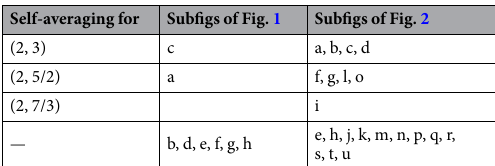
Self-averaging for Subfigs of Fig. 1 Subfigs of Fig. 2